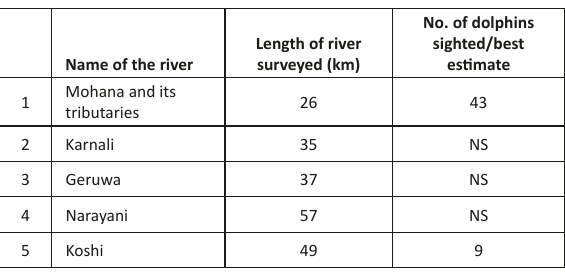
No. of dolphins sighted/best estimate